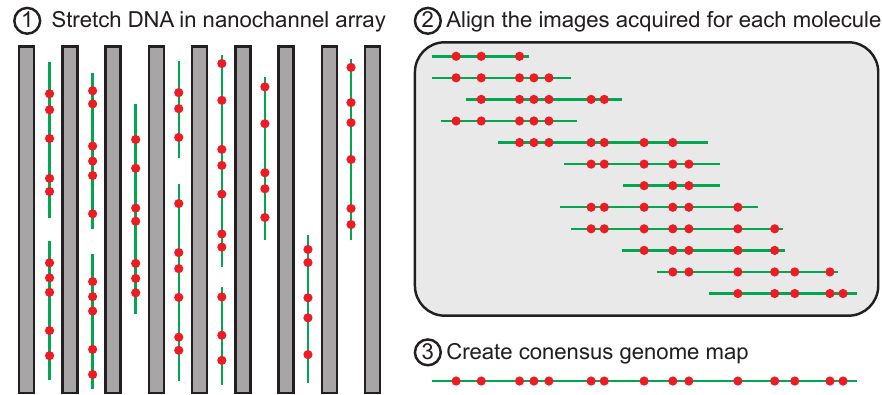
Figure 6. Schematic illustration of genome mapping in nanochannel arrays [38]. The green color corresponds to the fluorescent dye inserted into the DNA backbone, and the red color corresponds to sequence-specific labels inserted into the DNA. The goal of the experiment is to construct a consensus genome map by assembling the measurements of many fragments of the genome that have been stretched in the